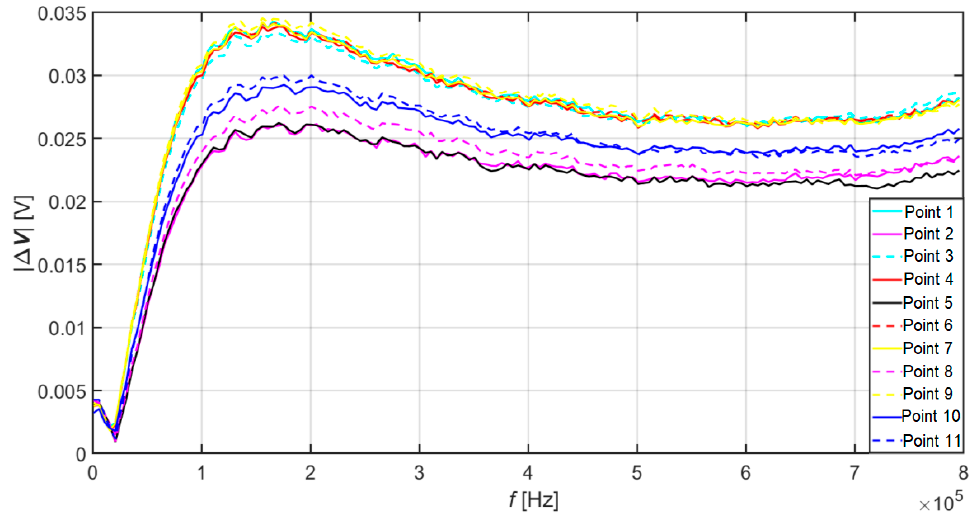
Figure 8. Graph of the absolute value of the voltage phasor of Specimen 4 corrosion crack.